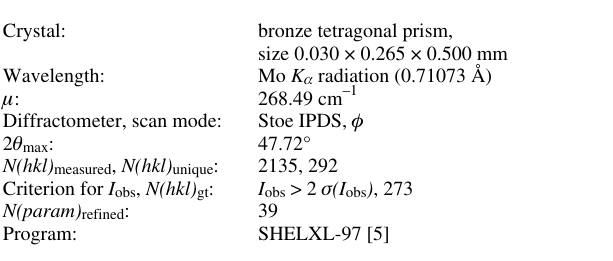
Table 1. Data collection and handling.